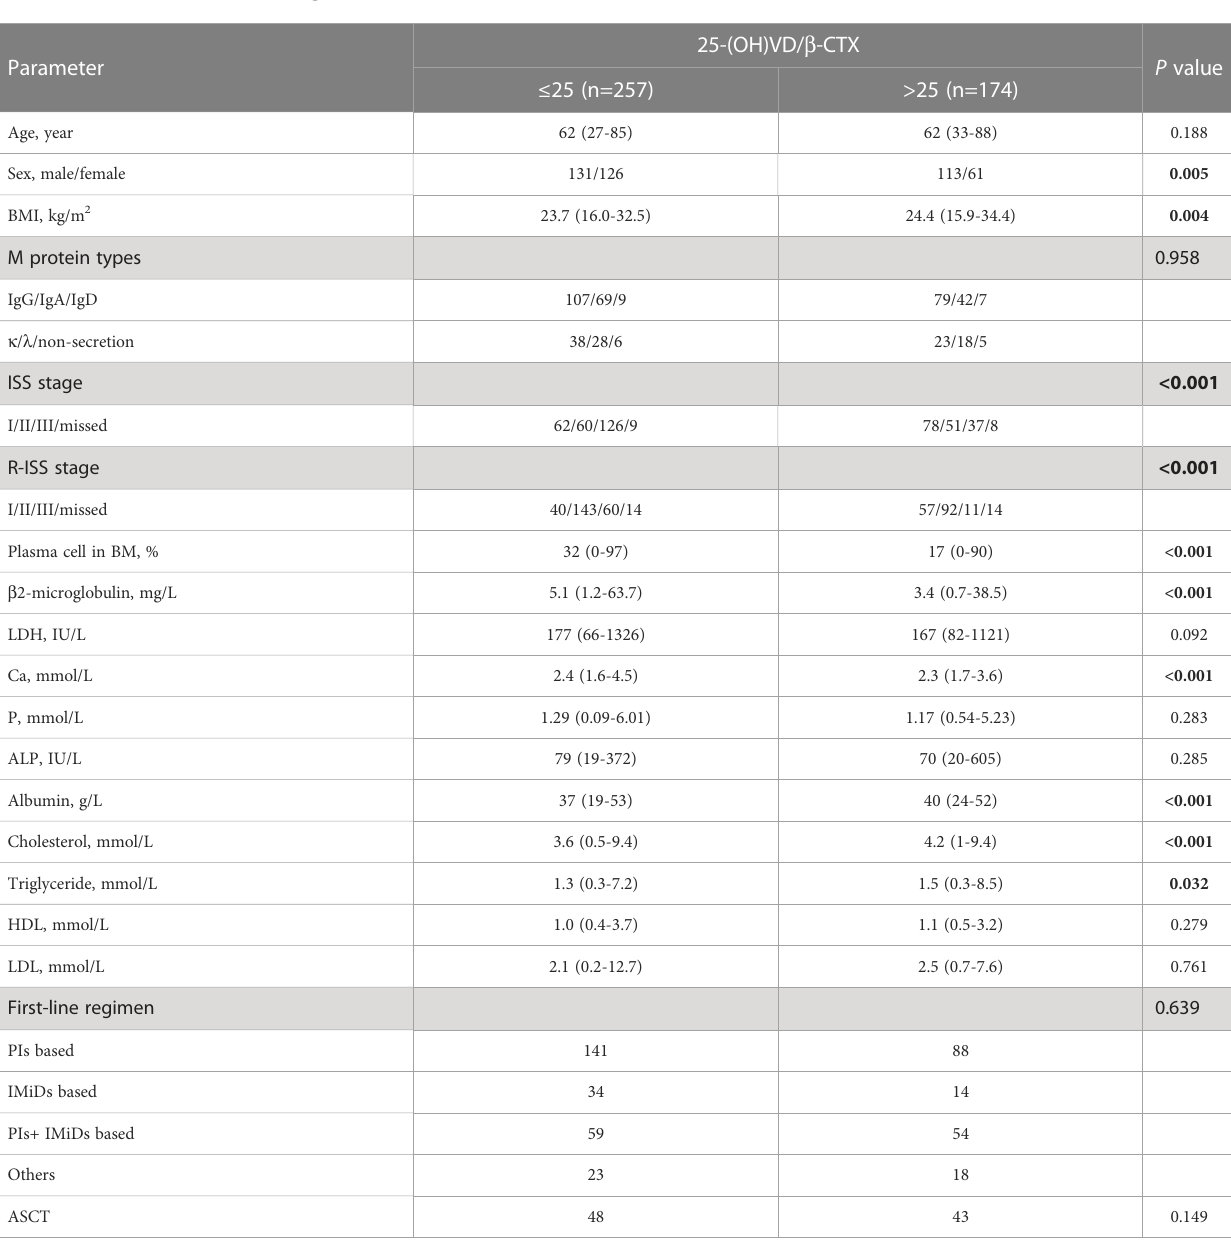
TABLE 1 Clinical characteristics at